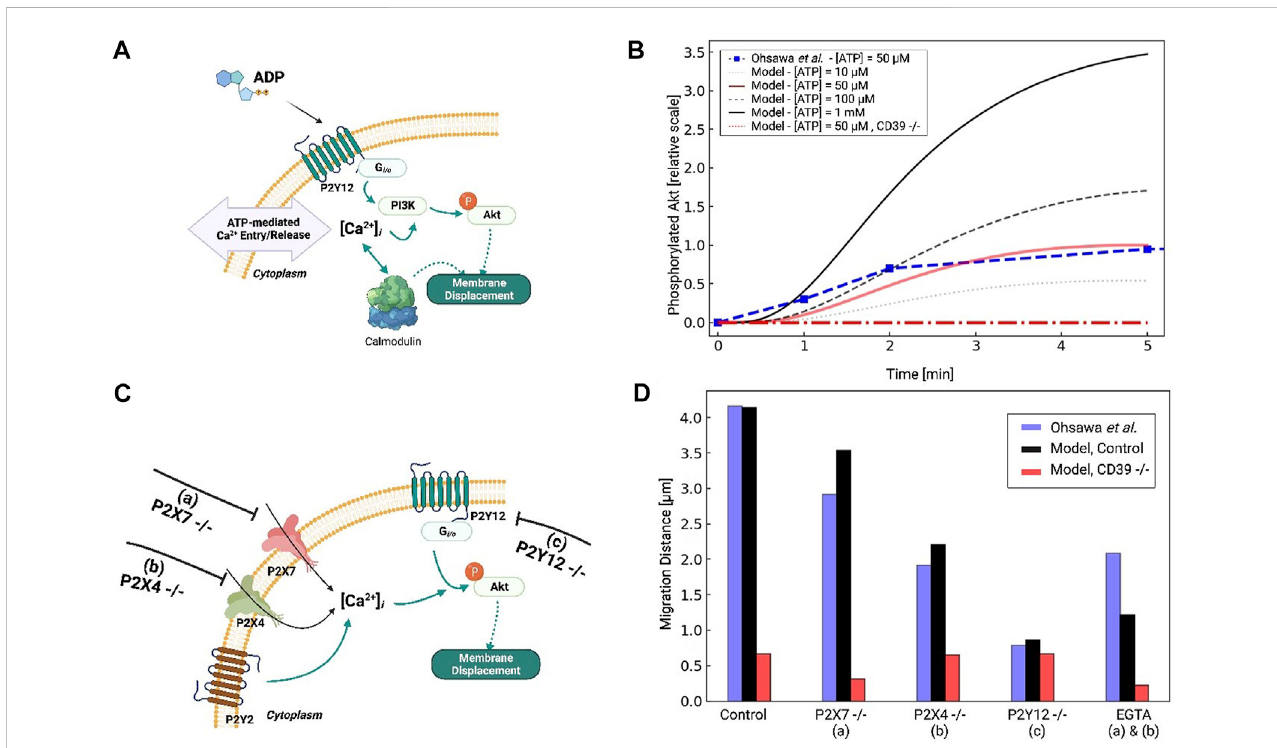
FIGURE 5 (A) Schematic of Akt phosphorylation via P 2 Y 12- and P 2 Y -mediated Ca 2+ signaling pathways in response to ATP. (B) Predicted p Akt level as a function of time in response to 50µM to 1 mM ATP applied for 5 min. Experimental data for 50 µM ATP from Ohsawa et al. (2004) are presented in red. (C) Schematic of